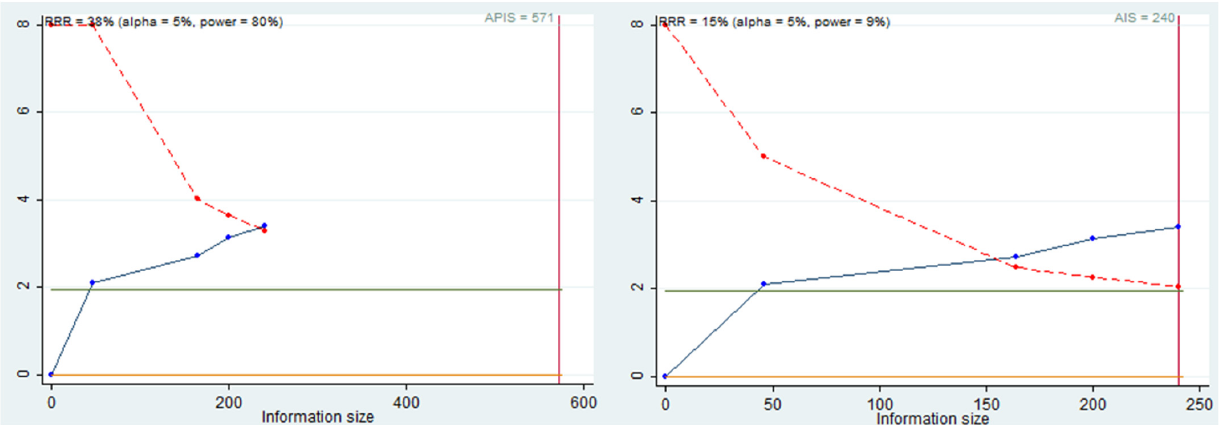
Figure 5. AIS, APIS, light green line (Z = 1.98), dashed red line (monitoring boundary), blue line (cumulative z curve), red line (sample size).